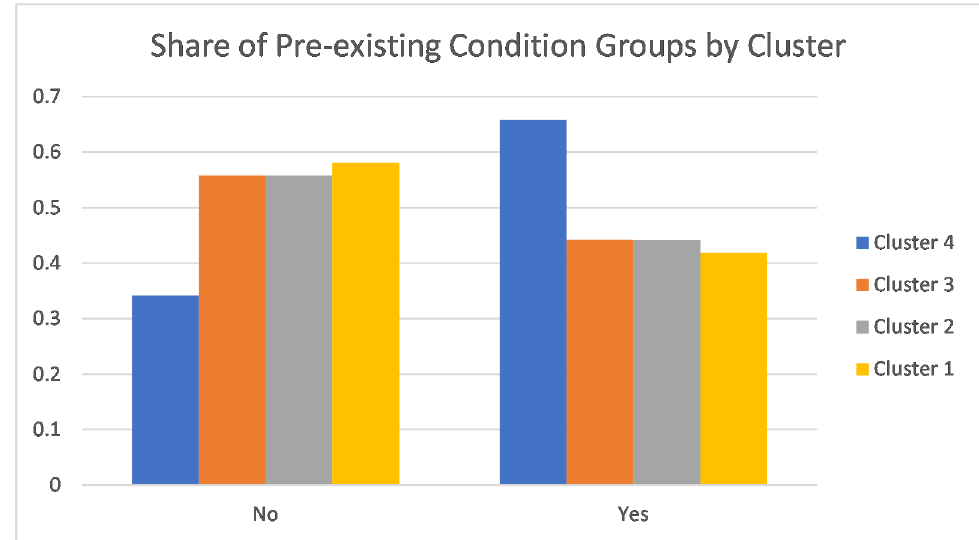
Figure 14. Proportion of individuals for each medical condition group allocated to clusters. Given as a percentage. Cluster 4 was the high-mortality